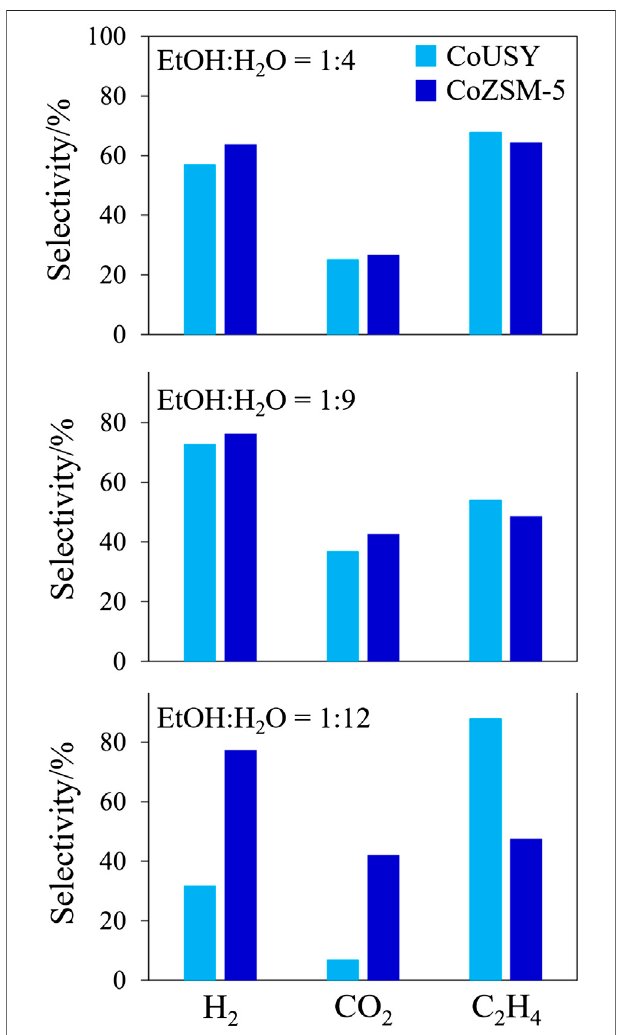
FIGURE 10 | The comparison of the selectivity to H 2 , CO 2 , and C 2 H 4 products at the 21st hour of the ESR process at 500 ° C under various conditions (ethanol-to-water molar ratio of 1 : 4, 1 : 9, and 1 : 12).